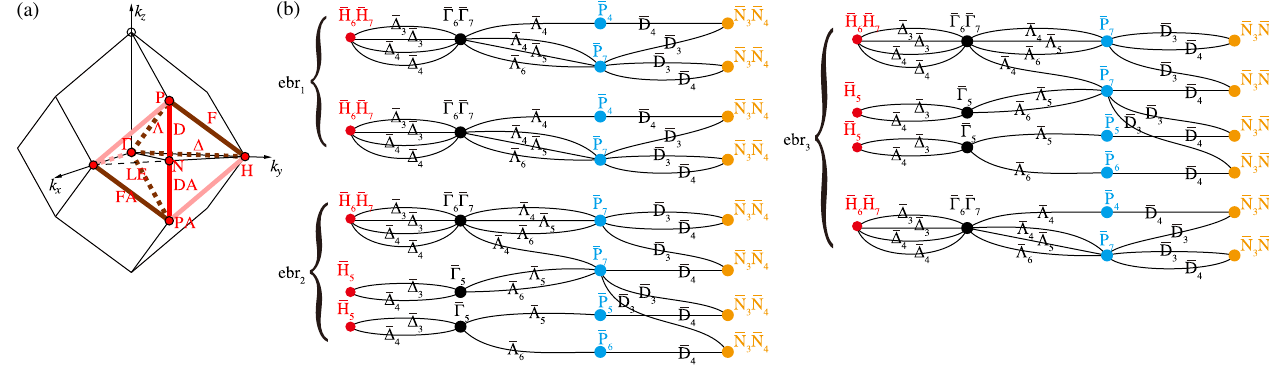
FIG. 2. (a) BZ of SG 199 ( I 2 1 3 ). (b) The EBRs of SG 199. The dots and lines represent high symmetry points and the high symmetry lines connecting the high symmetry points, respectively. The symbols of the irreps, e.g., Γ 6 Γ 7 , are defined on the REPRESENTATIONS DSG tool of the BCS [37,40,51].